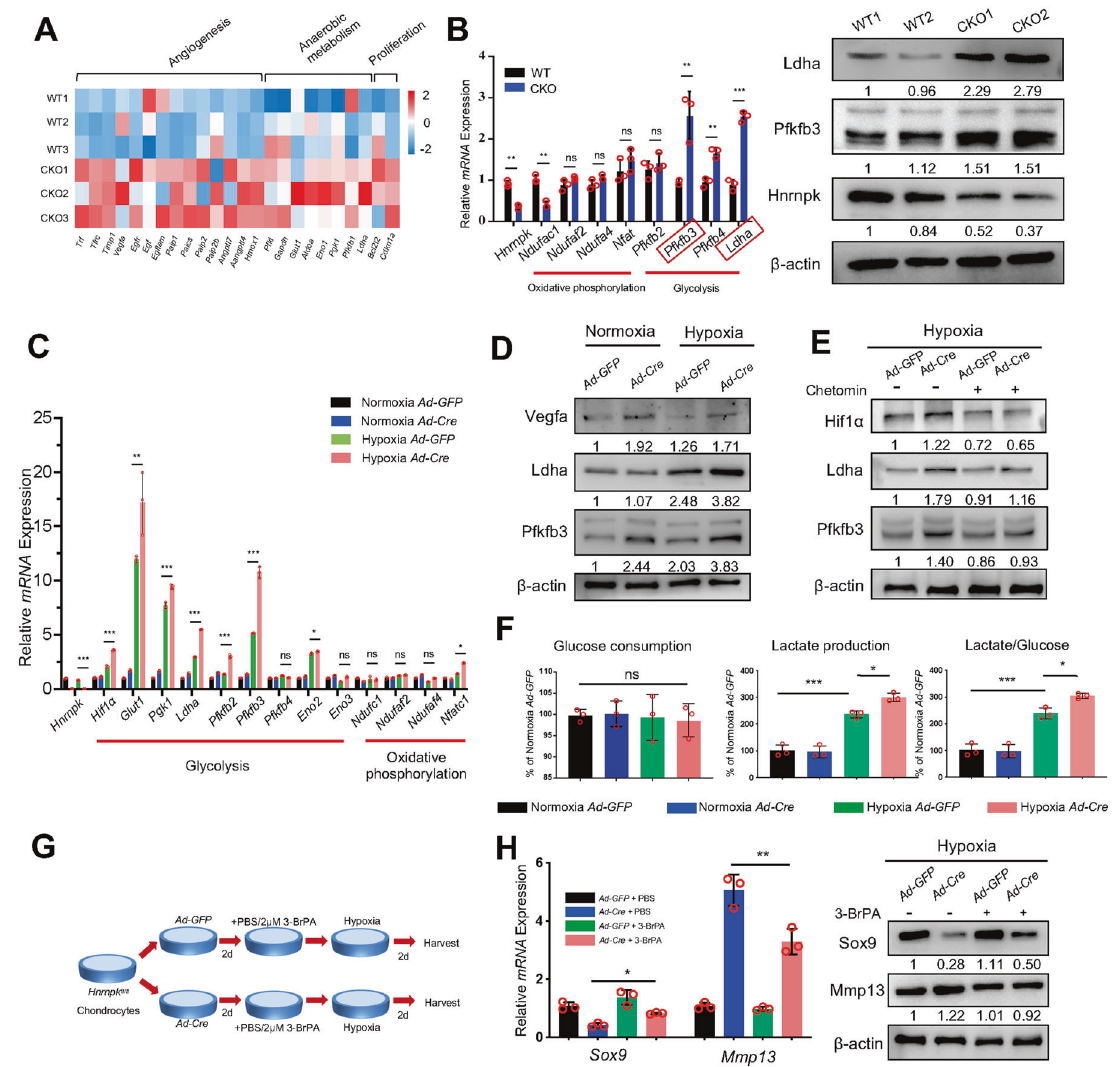
Fig. 5 Elevated activity of Hif-1 signaling pathway in Hnrnpk null chondrocytes increases glycolytic intensity. A mRNA fold changes of target genes of Hif-1 signaling pathway of E18.5 CKO growth plate cartilage compared to WT according to RNA-seq results. B mRNA expression level of key enzymes of oxidative phosphorylation and glycolysis of E18.5 WT and CKO growth plate cartilage (left panel). Protein level of Pfkfb3 and Ldha of E18.5 WT and CKO growth plate cartilage (right panel). Red boxes: most active glycolytic enzymes in chondrocytes. n = 3 biological replicates. Densitometry results were expressed as fold change in protein levels compared with WT1 after normalized to β -actin. C mRNA expression level of key enzymes of oxidative phosphorylation and glycolysis of Hnrnpk fl / fl chondrocytes infected with Ad-GFP or Ad-Cre under normoxic or hypoxic conditions. Statistical analysis was exerted between Hypoxia Ad-GFP and Hypoxia Ad-Cre . n = 3 biological replicates. D Protein level of Vegfa, Ldha, and Pfkfb3 of Hnrnpk fl / fl chondrocytes infected with Ad-GFP or Ad-Cre under normoxic or hypoxic conditions. Densitometry results were expressed as fold change in protein levels compared with chondrocytes infected with Ad-GFP under normoxic condition after normalized to β -actin. E Protein level of Hif1 α , Ldha, and Pfkfb3 of Hnrnpk fl / fl chondrocytes treated with DMSO or Chetomin after being infected with Ad-GFP or Ad-Cre under hypoxic condition. Densitometry results were expressed as fold change in protein levels compared with chondrocytes infected with Ad-GFP under hypoxic condition after normalized to β -actin. F Glucose consumption, lactate production, and ratio of lactate/glucose of Hnrnpk fl / fl chondrocytes infected with Ad-GFP or Ad-Cre under normoxia or hypoxic conditions. n = 3 biological replicates. G Diagram indicated the strategy of treating Hnrnpk fl / fl chondrocytes with PBS or 3-BrPA after being infected with Ad-GFP or Ad-Cre under hypoxic condition. H mRNA expression level and protein level of Sox9 and Mmp13 in Hnrnpk fl / fl chondrocytes treated with PBS or 3-BrPA after being infected with Ad-GFP or Ad-Cre under hypoxic condition. n = 3 biological replicates. Densitometry results were expressed as fold change in protein levels compared with chondrocytes infected with Ad-GFP under hypoxic condition after normalized to β -actin. p - value was calculated by one-way ANOVA followed by Tukey ’ s multiple comparisons tests ( C , F , H ) or two-tailed unpaired Student ’ s t -test ( B ). Data were shown as mean ± SD. * p < 0.05; ** p < 0.01; *** p < 0.001; ns: not signi fi hnRNPK was proven to interact with long non-coding RNA the mechanism that Hnrnpk degraded mRNA was still unknown. Lncenc1 to regulate the expression of glycolytic genes in mouse Previous studies proved that hnRNPK regulated the stability of embryonic stem cells (ESCs) through the transcriptional mechan- mRNA via interacting with other proteins [25, 49, 50]. Because of ism and knocking out hnRNPK decreased the transcription of the multifunction of hnRNPK, we hypothesized that Hnrnpk might glycolytic genes [51]. In chondrocytes, we proved that Hnrnpk interact with some other proteins to mediate the degradation of bound with the Hif1a mRNA and in fl uenced the activity of the Hif- Hif1a mRNA, which was worthy of further study.